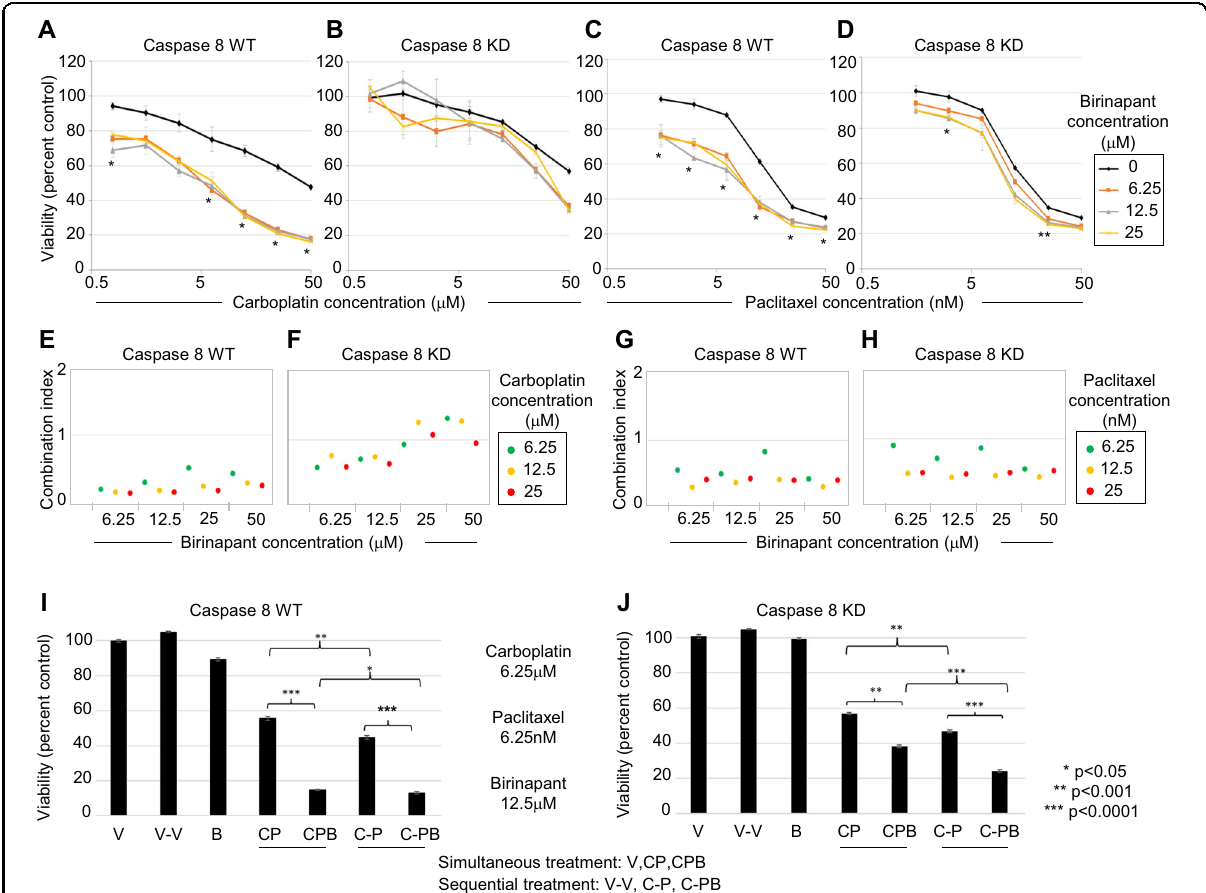
Fig. 2 Smac-mimetic birinapant synergizes with paclitaxel and antagonizes carboplatin in Caspase 8-depleted Ovcar8 cells in vitro. Ovcar8 cells transduced with control shRNA (Caspase 8 WT) ( A ) or Caspase 8 shRNA (Caspase 8 KD) ( B ), respectively, were simultaneously treated with varying concentrations of carboplatin and birinapant for 72 h. Cell viability was measured by XTT assay. Results are expressed as average ± S.E.M., n = 3, and shown as percentage of change from vehicle control; single asterisk (*) represents p < 0.05, double asterisks (**) p < 0.01 of 25 µM Birinapant versus carboplatin, based on t test. Ovcar8 cells transduced with either control shRNA (Caspase 8 WT) ( C ) or Caspase 8 shRNA (Caspase 8 KD) ( D ) were treated with varying simultaneous concentrations of paclitaxel and birinapant for 72 h, and cell viability was assessed as described above. E – H Combination indexes for the matched Ovcar8 cell lines at 6.25 µM (green) 12.5 µM (yellow), and 25 µM birinapant 2 concentrations were analyzed by Compusyn and indicated on graphs. I , J Ovcar8 cells transduced with either control shRNA or Caspase 8 shRNA were simultaneously or sequentially treated with 6.25 µM carboplatin, 6.25 nM paclitaxel, and 12.5 µM birinapant for 72 h. Cell viability was measured by XTT assay as described. Results are expressed as average ± S.E.M., n = 6, and shown as percentage of change from vehicle control. UT untreated, V drug vehicle alone, B birinapant, CP carboplatin/paclitaxel, CPB carboplatin/paclitaxel/birinapant, V-V drug vehicle 24 h + drug vehicle 48 h, C-PB carboplatin 24 h + paclitaxel/birinapant 48 h, C-P carboplatin 24 h + paclitaxel 48 h. Single asterisk (*) represents p < 0.05, double asterisks (**) p < 0.001, triple asterisks (***) p < 0.0001 based on t test for the indicated comparisons, shown as percentage of change from